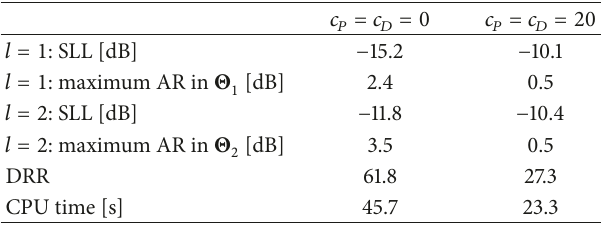
Table 1: First application: overall